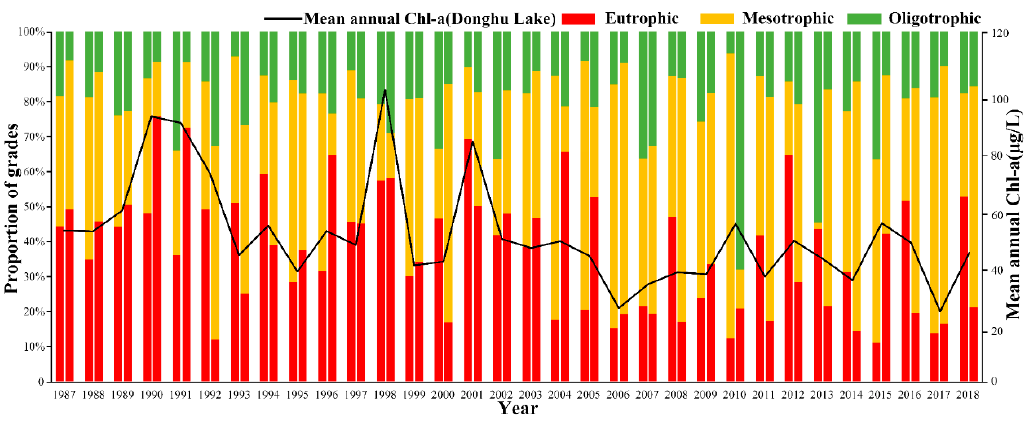
Figure 7. The area ratio of different Chl-a concentration grades from 1987 to 2018. The black solid line represents the annual mean value of Chl-a. The column on the left represents the proportion of grades in spring of different years and the column on the right represents that in autumn.